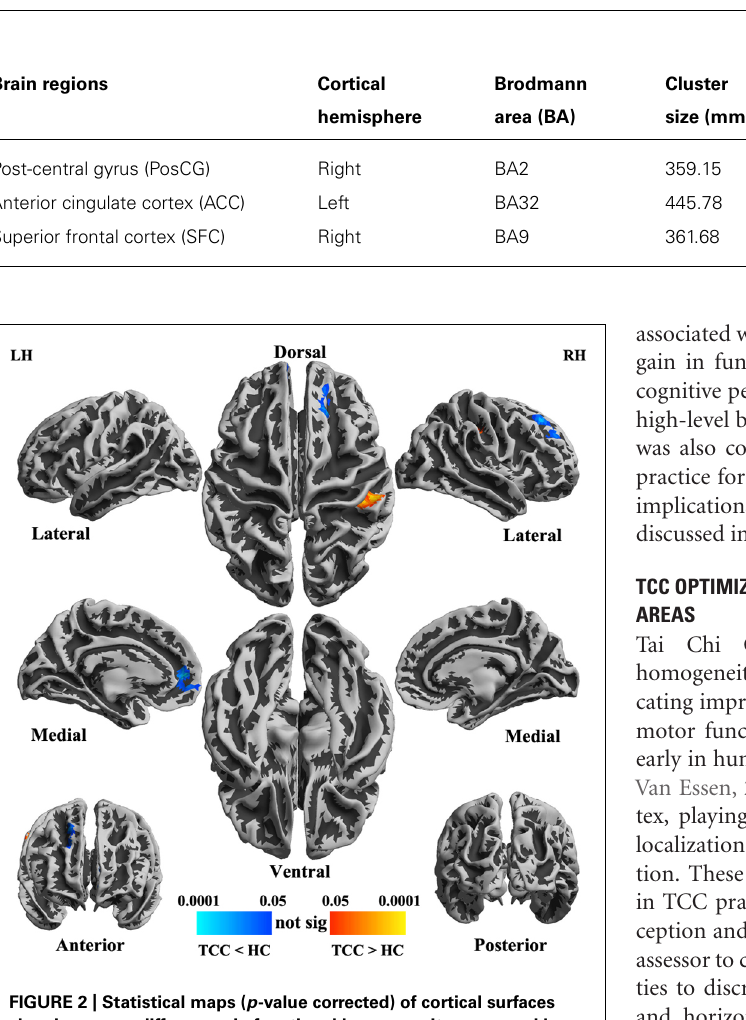
FIGURE 2 | Statistical maps ( p -value corrected) of cortical surfaces showing group differences in functional homogeneity measured by 2dReHo in fsaverage5 standard space. InTCC experts (compared to healthy control subjects), blue colors indicate decreases in 2dReHo, while red colors indicate increases in